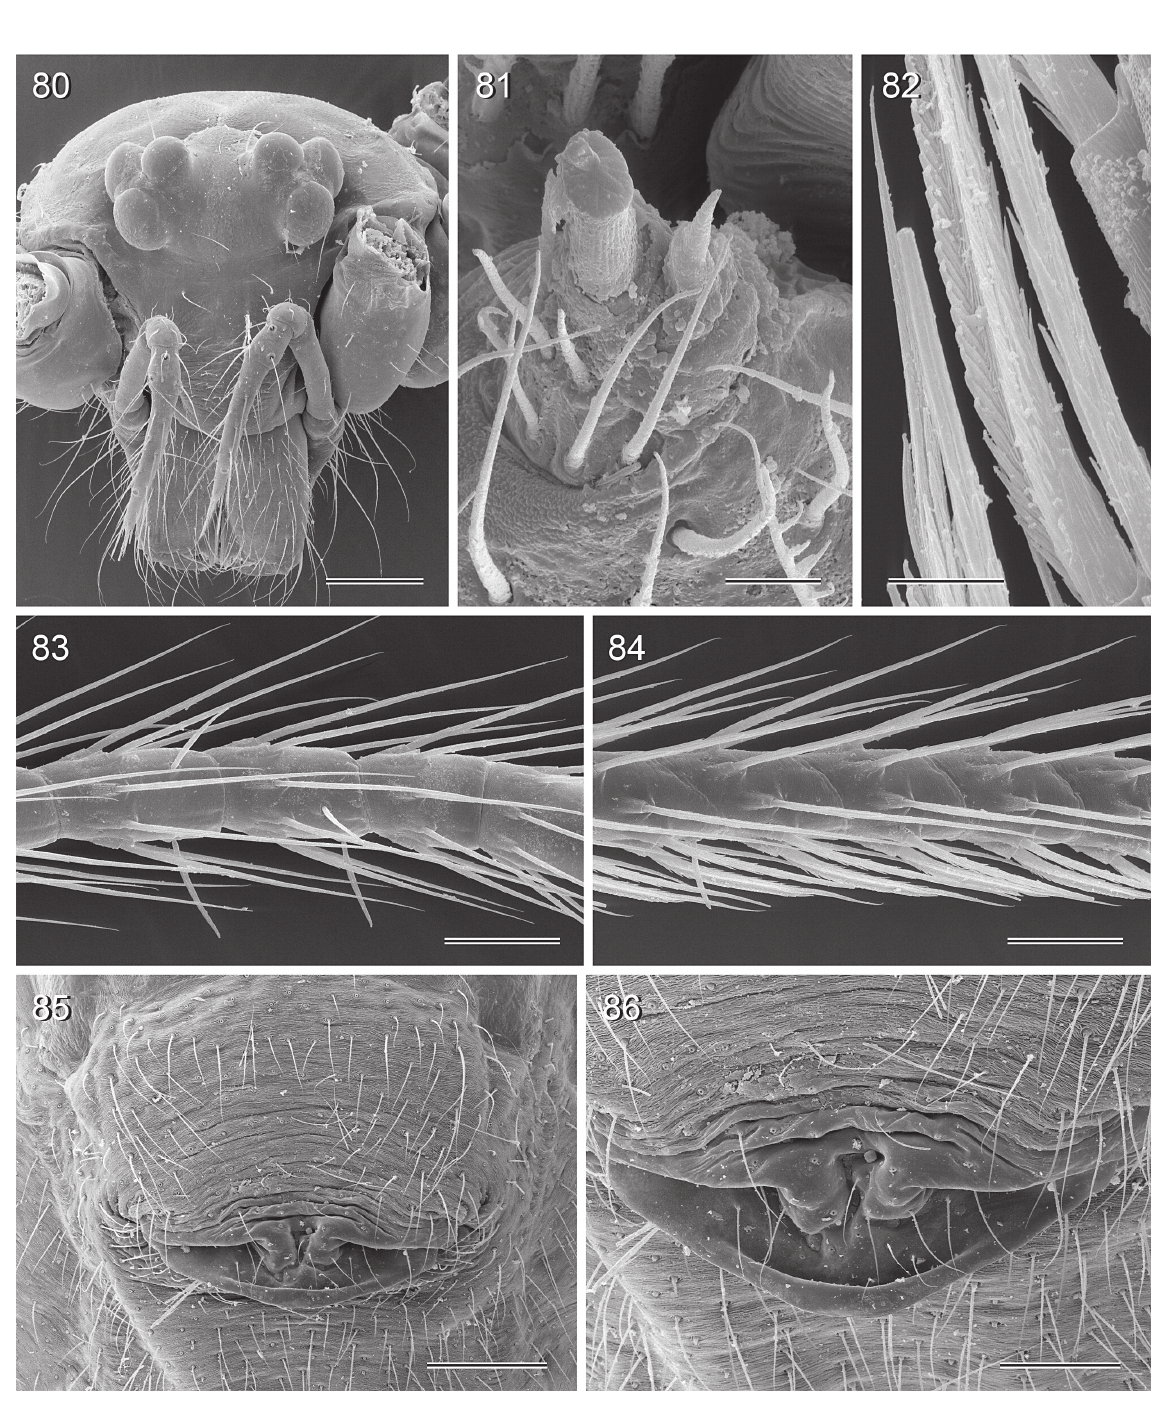
Figs 80–86. Aetana loboc Huber, sp. nov. 80 . Female prosoma, frontal view. 81 . Female ALS. 82 . Comb-hair on female tarsus 4. 83 . Detail of female tarsus 1. 84 . Detail of female tarsus 4. 85 . Epigynum. 86 . Detail of preceding. Scale lines: 80, 85 = 200 µm; 81 = 10 µm; 82 = 8 µm; 83–84 = 40 µm; 86 = 100